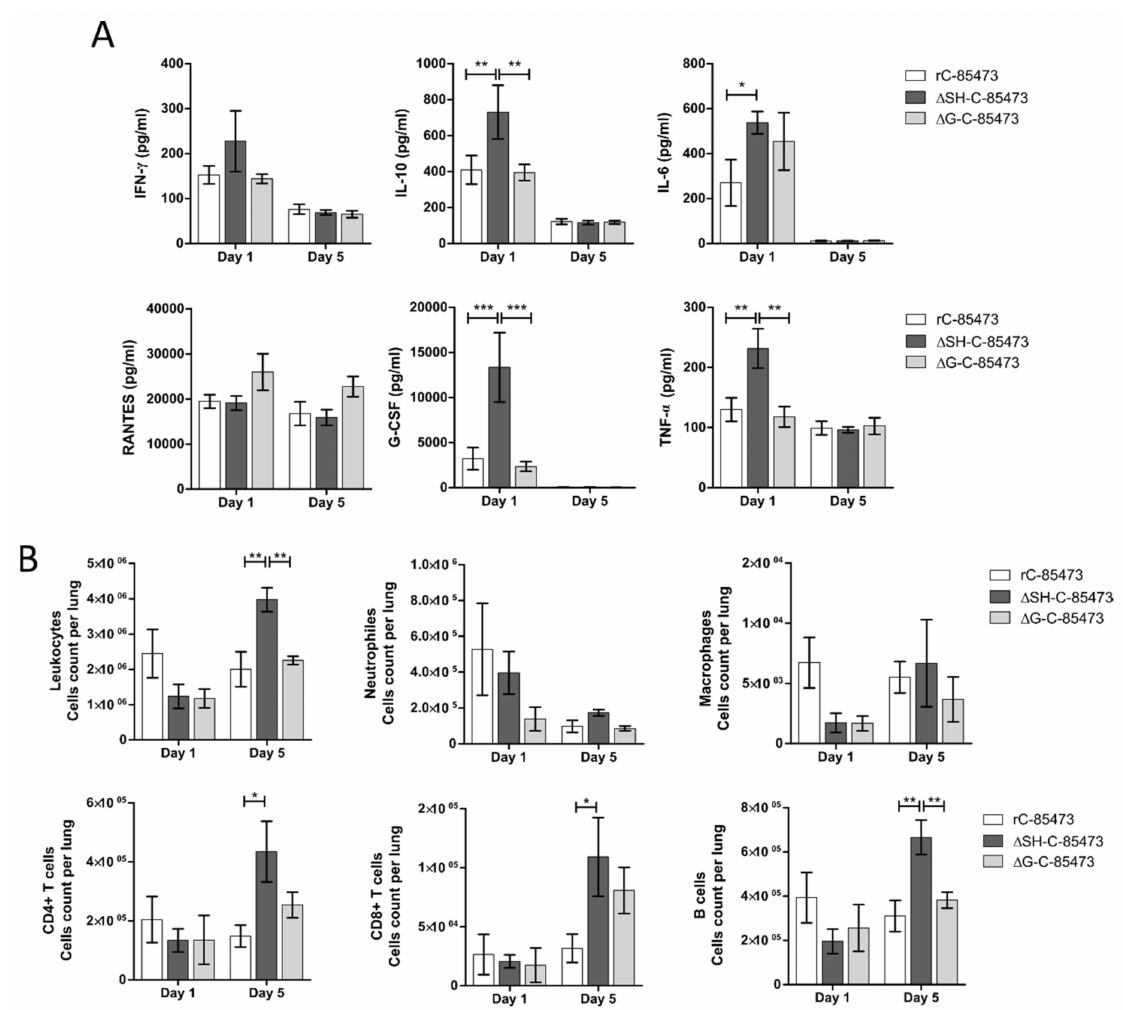
Figure 6. HMPV-immunized mice showed distinct cytokine / chemokine and immune cell infiltration profiles through time after viral challenge. BALB / c mice were intranasally immunized with 5 ∆ SH-C-85473, ∆ G-C-85473 or WT rC85473 viruses (immunization control), as × 10 5 TCID 50 of previously described. Three weeks after immunization, animals were inoculated with 1 × 10 6 TCID 50 (LD 50 ) of rC-85473 (viral challenge). ( A ) Pulmonary inflammatory cytokine / chemokine levels in HMPV-immunized challenged mice were determined from lung homogenates on days one and five post-challenge, using a multiplex bead-based assay. Six cytokines / chemokines (IFN- γ , IL-10, IL-6, RANTES, G-CSF, TNF- α ) were selected considering both their detection levels and significance in HMPV-related disease. ( B ) Immune cell infiltration in lung homogenates was evaluated by flow cytometry on days one and five post challenge. * p < 0.05; ** p < 0.01; *** p < 0.001 comparing each group using repeated measures two-way